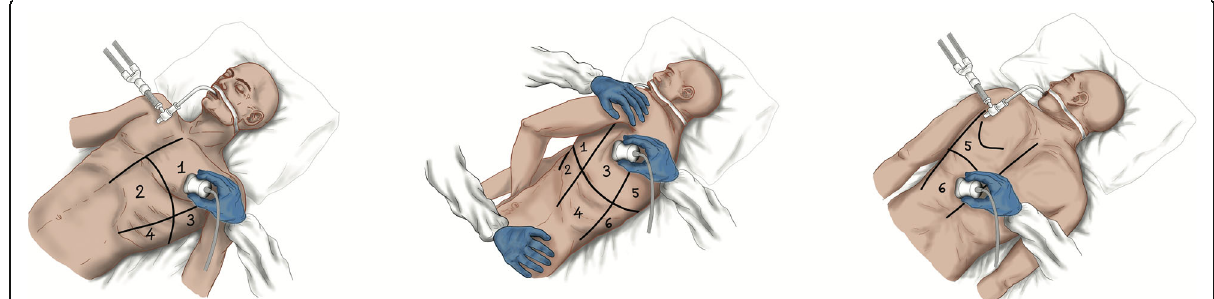
Fig. 2 The lung ultrasound score (LUS) can be applied to assess the loss of aeration by dividing the thorax into 12 specific regions, six on the right and six on the left in supine or prone position assign each region a score from 0 (normal lung) to 3 (lung consolidation). Anterior, lateral, and posterior fields are identified by sternum, anterior, and posterior axillary lines. The entire examination can be performed without any change in patient ’ s position. Score: 0 = normal aeration (A-lines and lung sliding or maximum 2 well-spaced B-lines); score 1 = moderate loss of aeration (> = 3 well-spaced B-lines with lung sliding, coalescent B-lines/subpleural consolidations occupying < 50% of the pleural line); score 2 = severe loss of aeration (> = 3 well-spaced B-lines with lung sliding, coalescent B-lines/subpleural consolidations occupying clearly > 50% of the pleural line); score 3 = complete loss of aeration: lobar/hemilobar consolidation with predominant tissue like